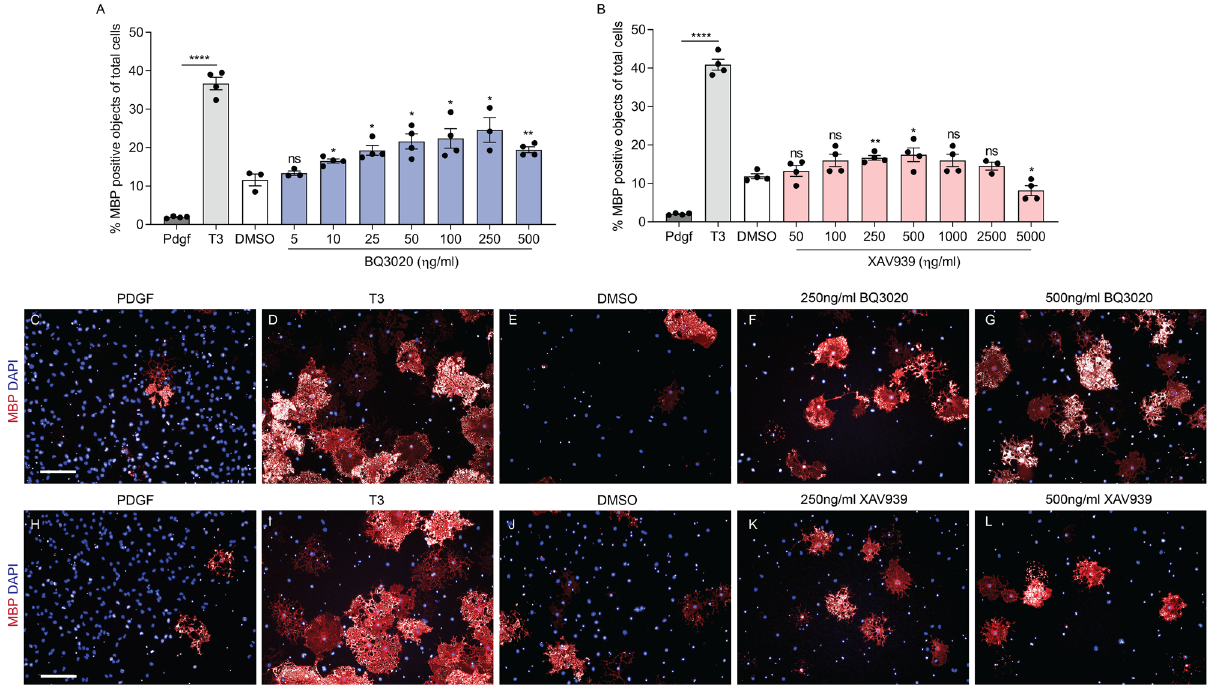
Figure 3. BQ3020 and XAV939 promote OPC differentiation in vitro . Differentiated OLs quantified by MBP + stained cells (%) normalized to total cell number. Four-day treatments of O4 + OPCs with increasing concentrations of ( A ) BQ3020 (5–500 ng/ml) and ( B ) XAV939 (25–5000 ng/ml) were compared to DMSO control. ( C , H ) PDGF (10 ng/ml) and ( D , I ) T3 (40 ng/ml) are displayed and quantified as negative and positive controls, respectively. Representative immunofluorescent images of OPC/OLs monoculture highlighting nuclei in blue (DAPI) and differentiated cells in red (MBP) in ( E , J ) DMSO control condition and ( F , K ) 250 ng/ml BQ3020 and XAV939 and ( G , L ) 500 ng/ml BQ3020 and XAV939 conditions respectively (scale bar 100 µm). Individual values show mean ± SEM; 3–4 biological replicates were done, analysis was done by an unpaired t-test with 95% confidence interval, ns not significant, *P < 0.05, **P < 0.01, ***P < 0.001, ****P <